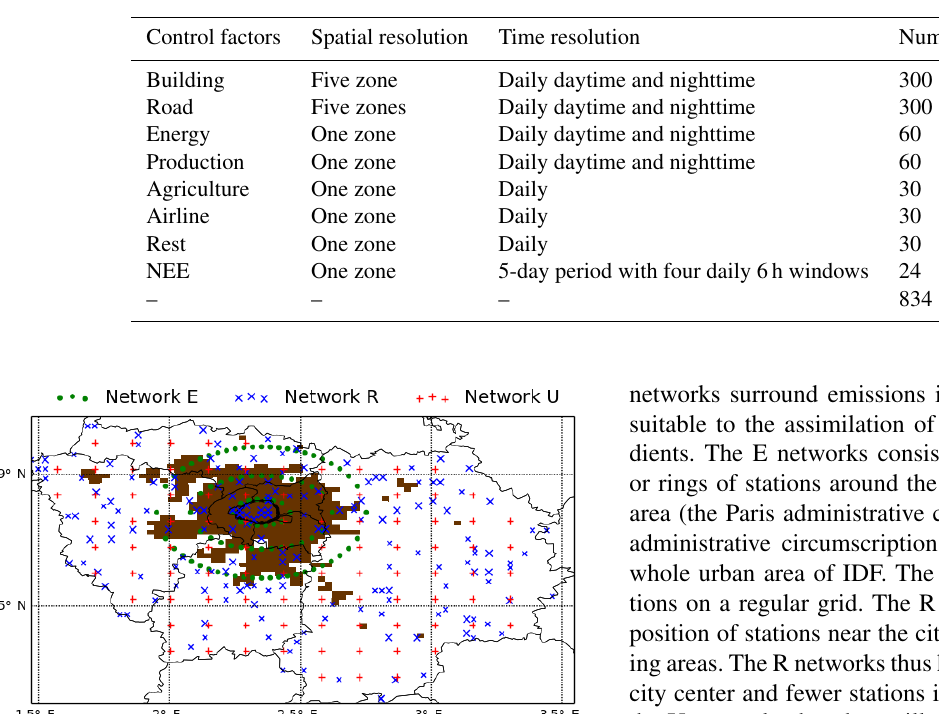
Table 1. Spatiotemporal resolutions of the sectoral control factors for inversions over 30-day periods (see the main text and Table A1 for more information on aggregate sectors).